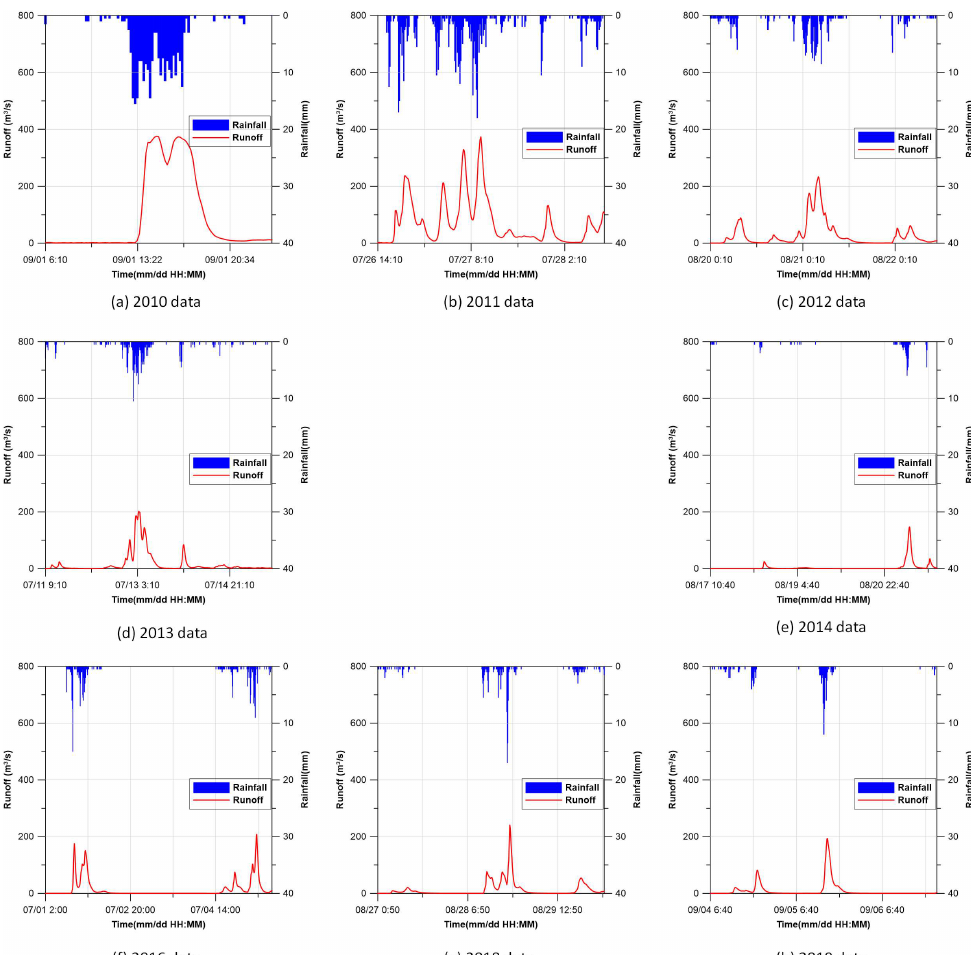
Figure 3. Observed rainfall and runoff data in Dorim stream.